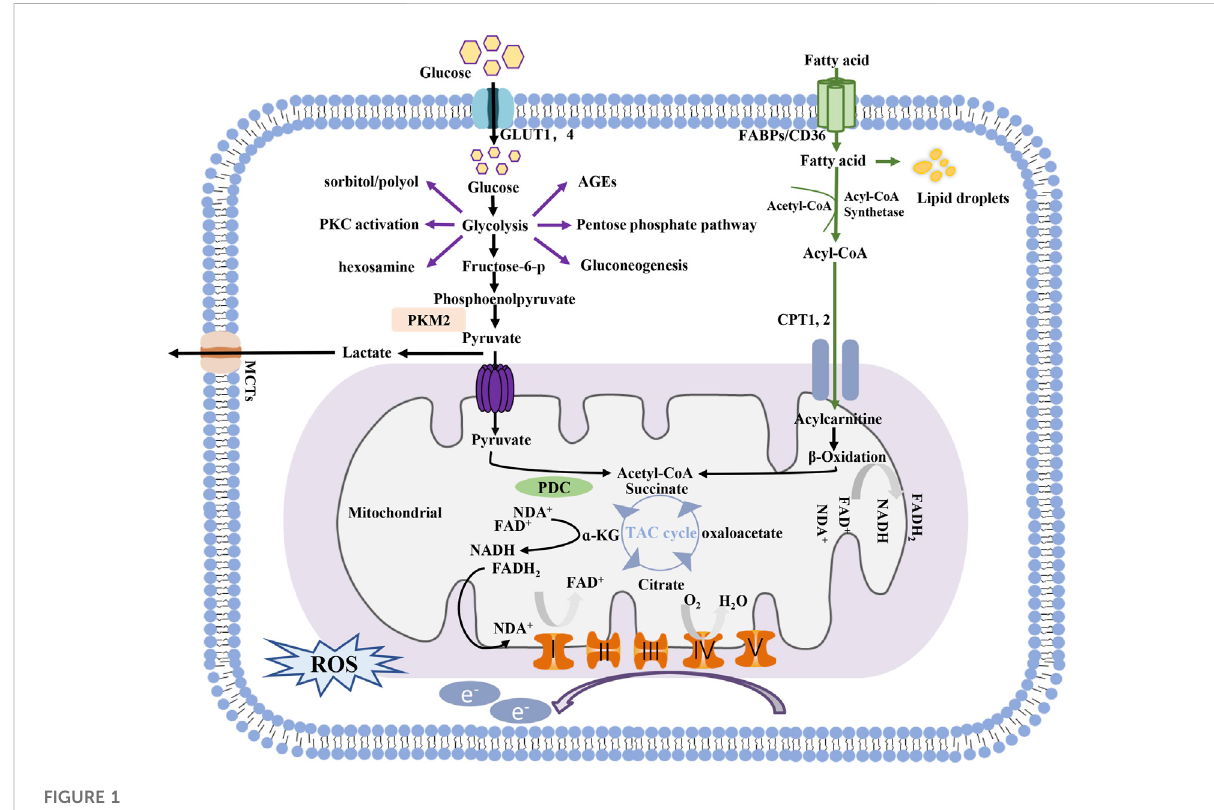
FIGURE 1 Process of energy metabolism in